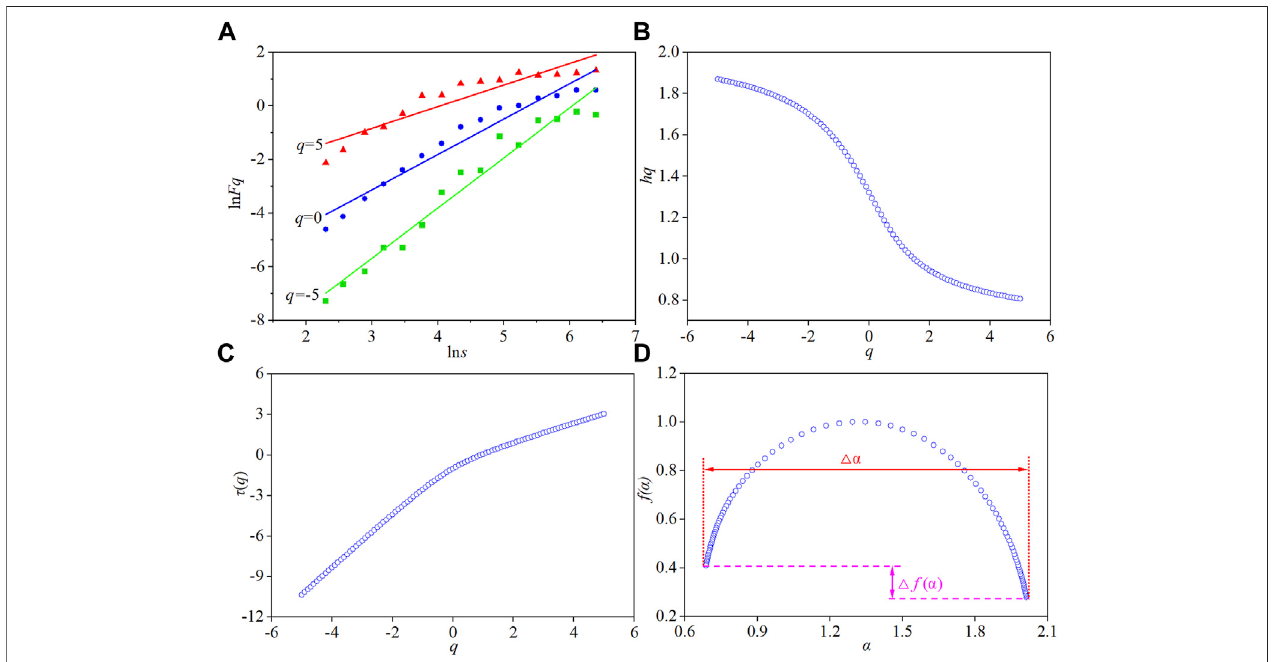
FIGURE 4 | MF-DFA results of the microseismic waveform. (A) Relationship between ln s and ln F q ; (B) q-order Hurst exponent; (C) q-order mass exponent; and (D) multifractal